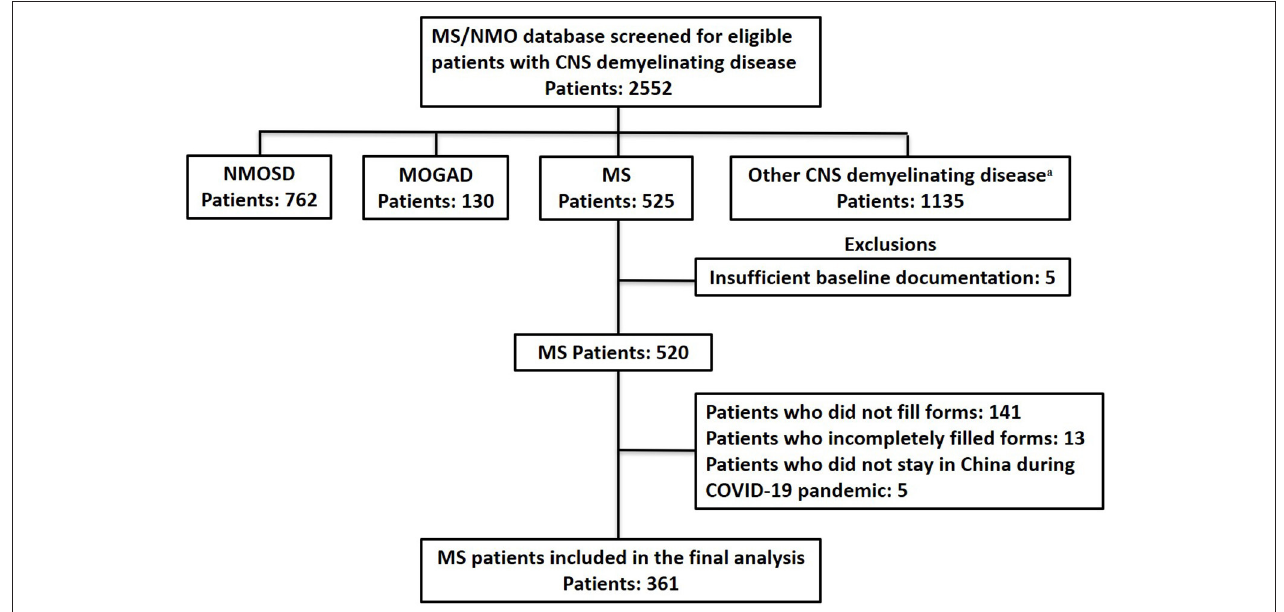
FIGURE 2 | Flow chart of data processing and exclusions. COVID-19, coronavirus disease 2019; MOGAD, Myelin Oligodendrocyte Glycoprotein Antibody Associated Disorders; MS, Multiple Sclerosis; NMOSD, Neuromyelitis Optica Spectrum Disorder. a Other CNS demyelinating disease: acute myelitis, brain stem encephalitis, aute disseminated encephalomyelitis, autoimmune GFAP astrocytopathy, and connective tissue